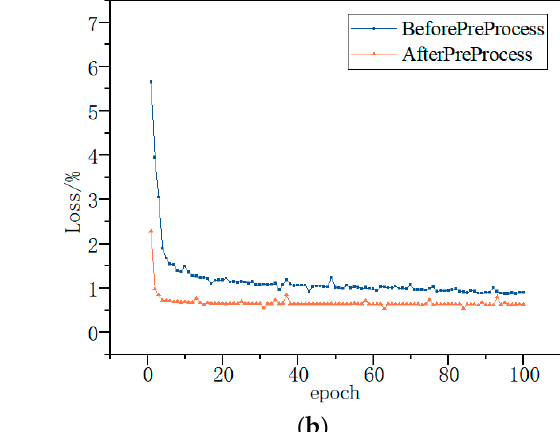
Figure 12. DataCon dataset accuracy and loss; they should be listed as: ( a ) Description of accuracy; ( b ) Description of loss.